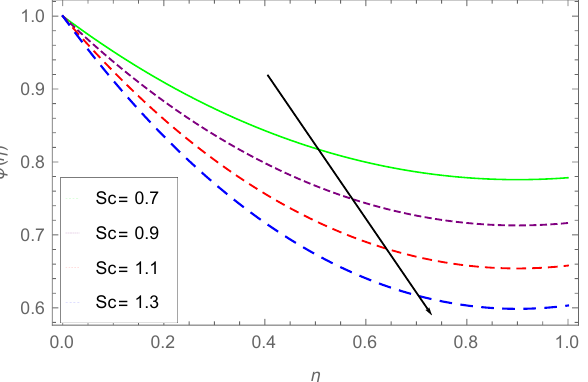
Figure 15. Impact of Sc on φ ( η ) , when S = 0.7, (cid:101) = 0.8, β = 0.9, Pr = 0.6, Nb = 0.8, Nt = 0.4.